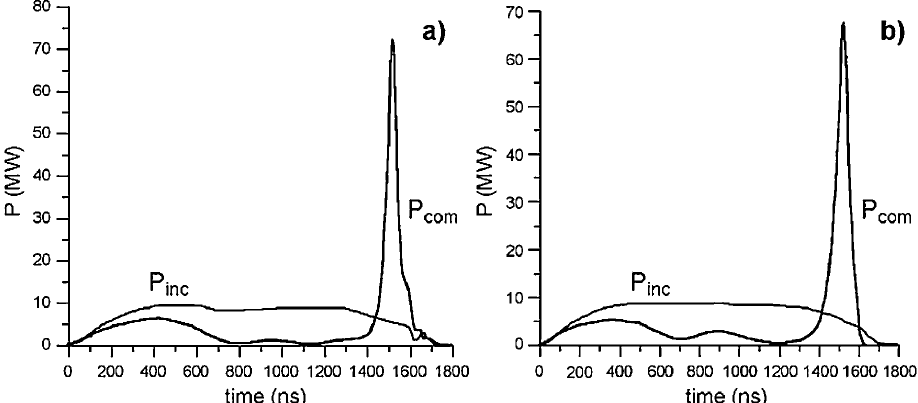
FIG. 13. Sample oscilloscope traces of the incident and compressed pulse for the two-channel compressor with the switch based on mode conversion. The gas pressure in the tubes was 0.04 Torr. (a) Power of the compressed pulse (cid:5) 71 MW , pulse duration (cid:5) 49 ns , peak power gain (cid:5) 8 : 4:1 , power of the incident pulse (cid:5) 8 : 5 MW ; compression efficiency (cid:5) 48% . (b) Power of the compressed pulse (cid:5) 68 MW , pulse duration (cid:5) 69 ns , peak power gain (cid:5) 8:1 , power of the incident pulse (cid:5) 8 : 5 MW ; compression efficiency (cid:5) 61%